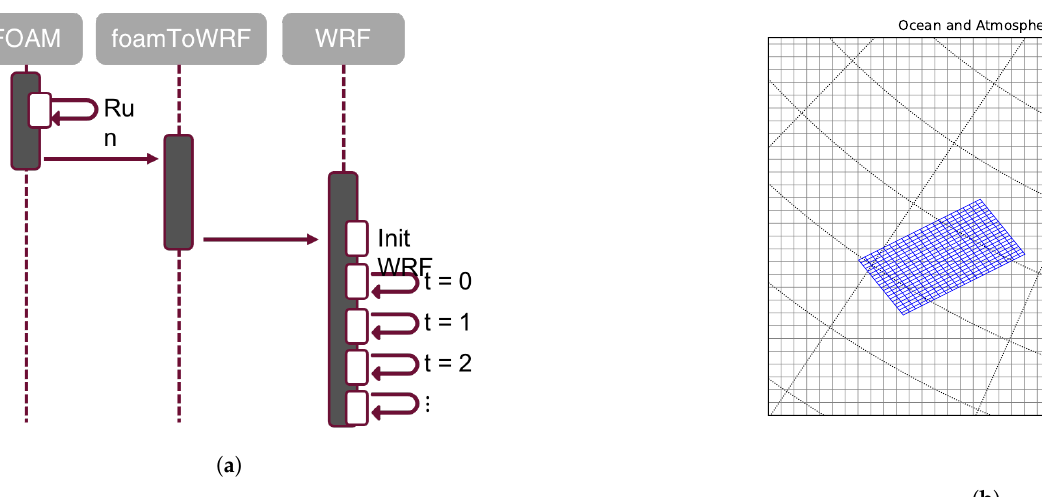
Figure 1. ( a ) Illustration of the one-way coupling algorithm. The ocean model (FOAM) is run prior to the atmospheric model to generate the required bottom boundary conditions. ( b ) Depiction of the possible disparate meshes that can exist between ocean and atmospheric model components. The ocean domain, drawn in blue, at a finer grid resolution, and not aligned with the underlying atmospheric